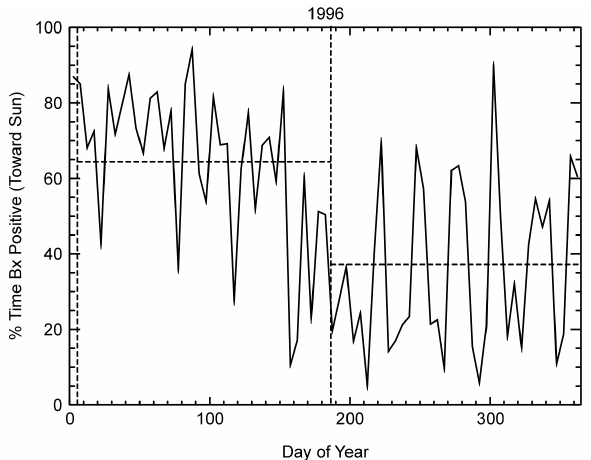
Fig. 5. Evolution of the “tilt angle” of the heliospheric current sheet from 1990–2000. The dashed vertical lines bracket